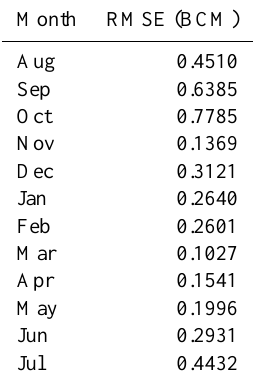
Table 6. RMSE associated with Ensemble ANN forecasting model for the period 1961–2000 and the lead time for two months